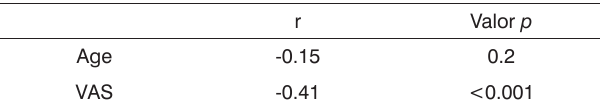
Table 4. Spearman correlation coefficient (r) between NIPF with VAS and age.